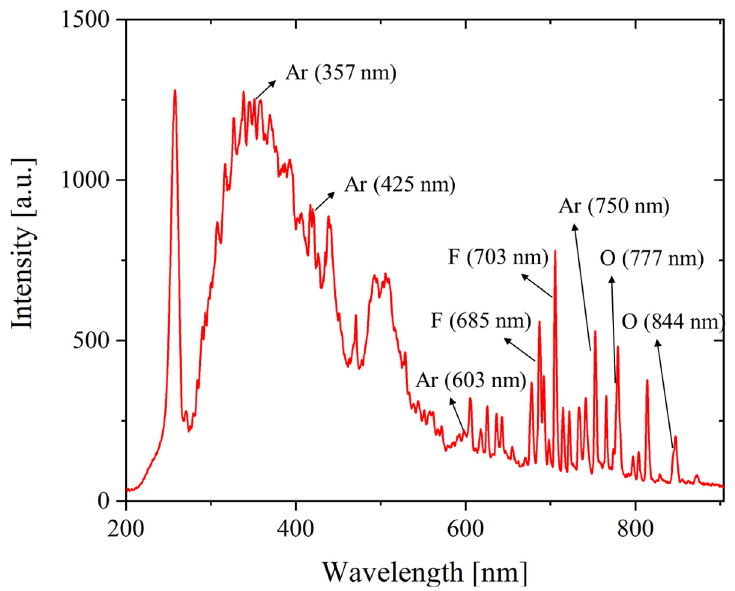
Figure 3. OES full-spectrum and selected wavelengths.